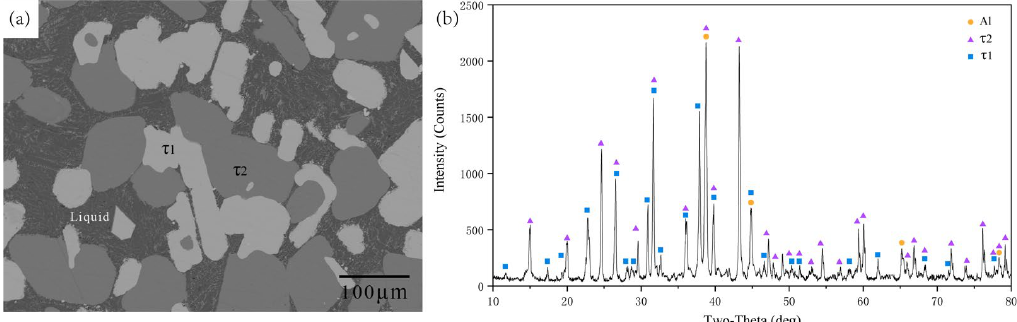
Figure 11. Sample B4’s ( a ) BSE image and ( b ) XRD pattern.